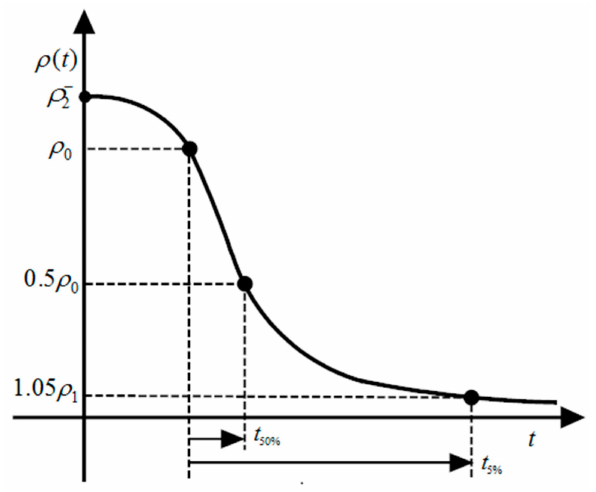
Figure 3. Illustration of the times t 50% and t 5%